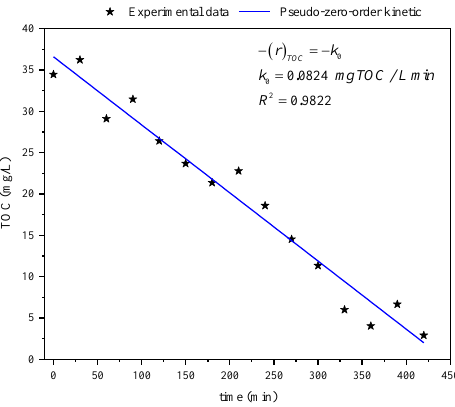
Figure 5. Decay kinetics of electrochemical mineralization of IBU.